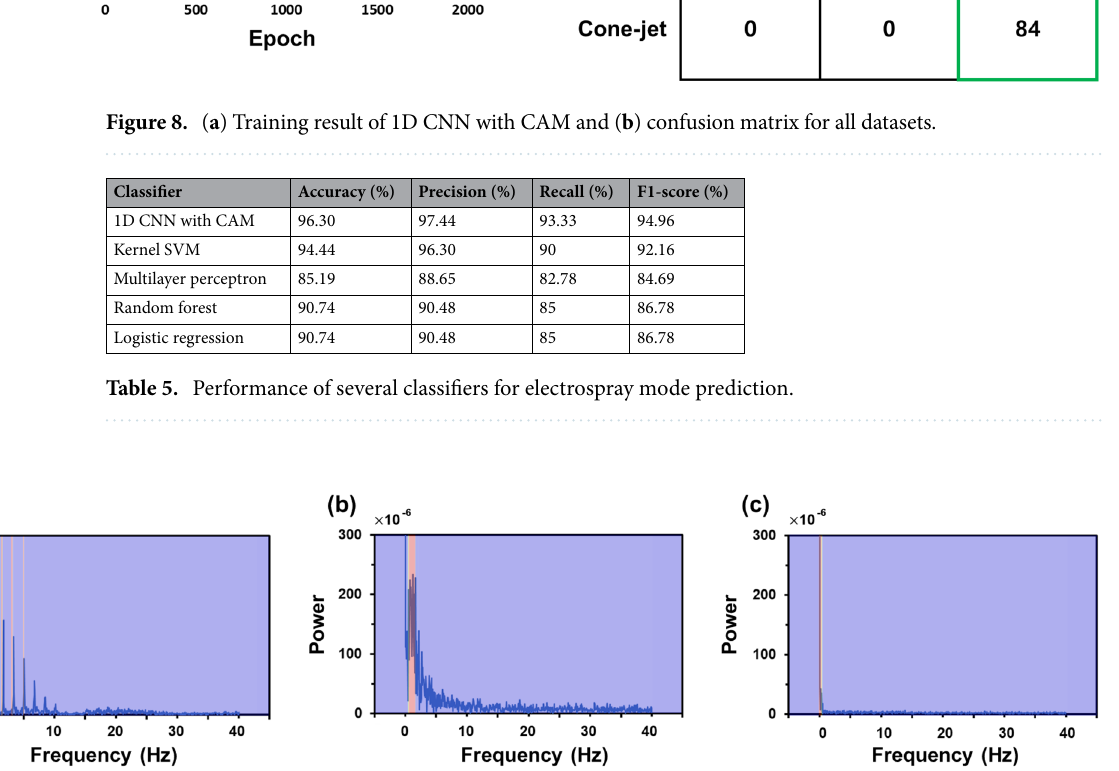
Figure 9. Images of overlapping CAM heat map on frequency data: ( a ) dripping, ( b ) pulsating, and ( c )